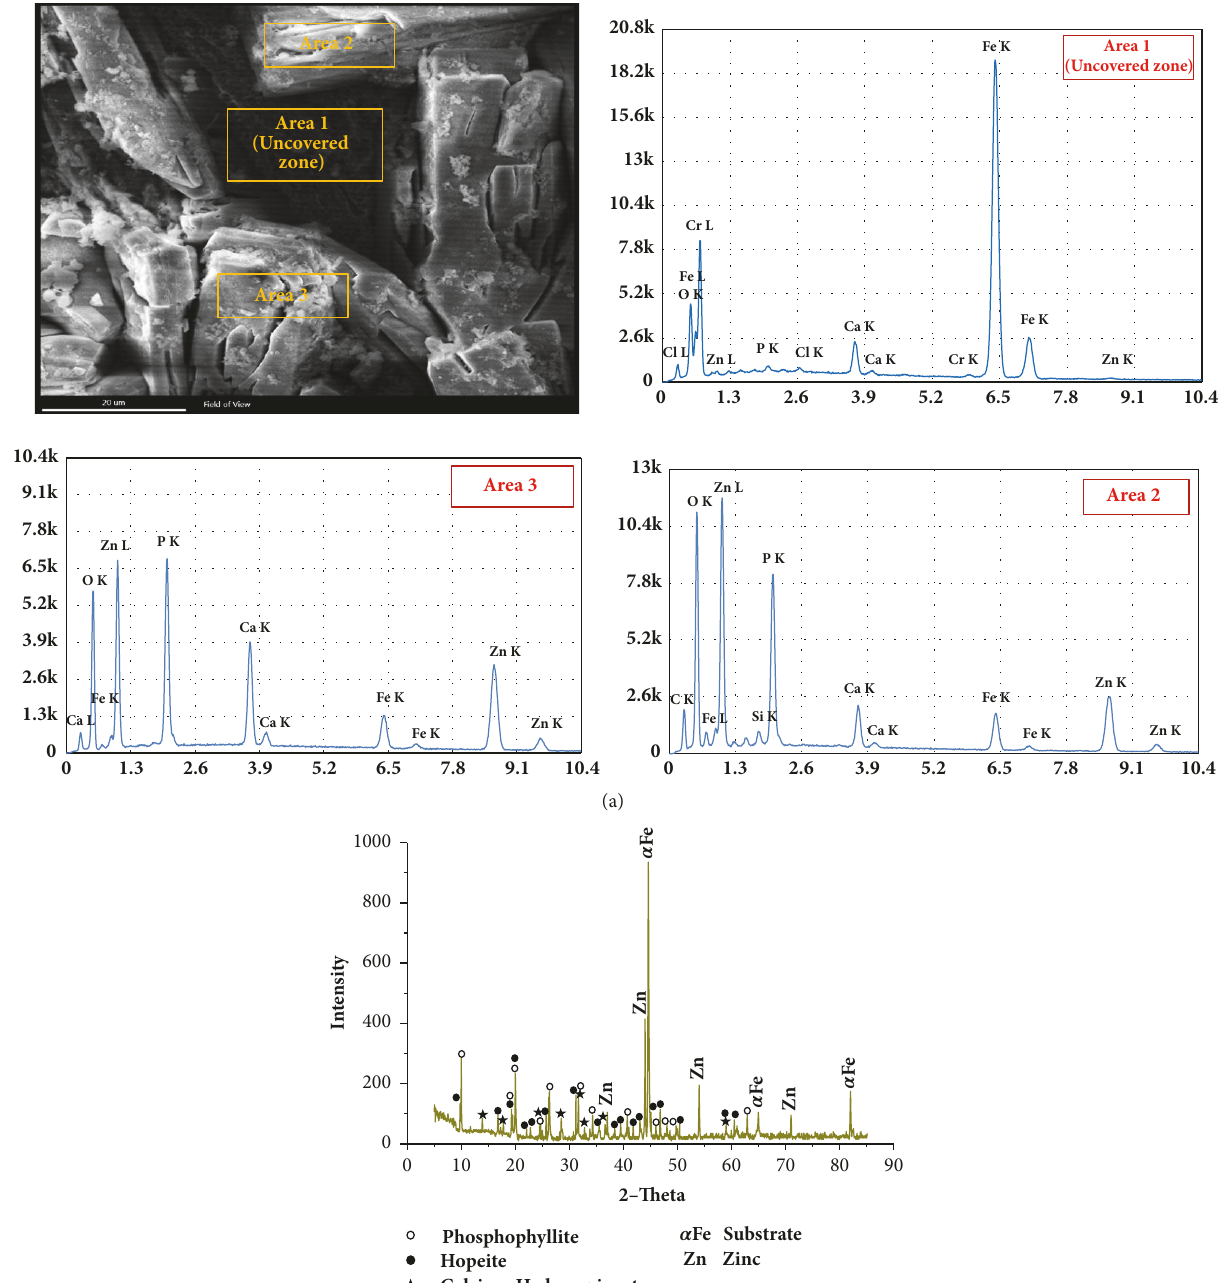
Figure 17: SEMs and EDX (a) and XRD analysis (b) of ZnP coating after immersion in (CH-Cl) solution for 96 h.